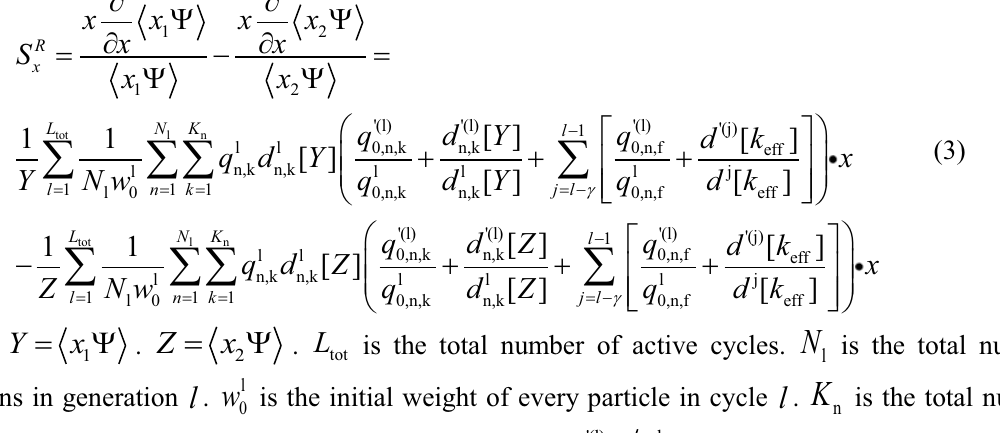
represents the relative change in the probability of the